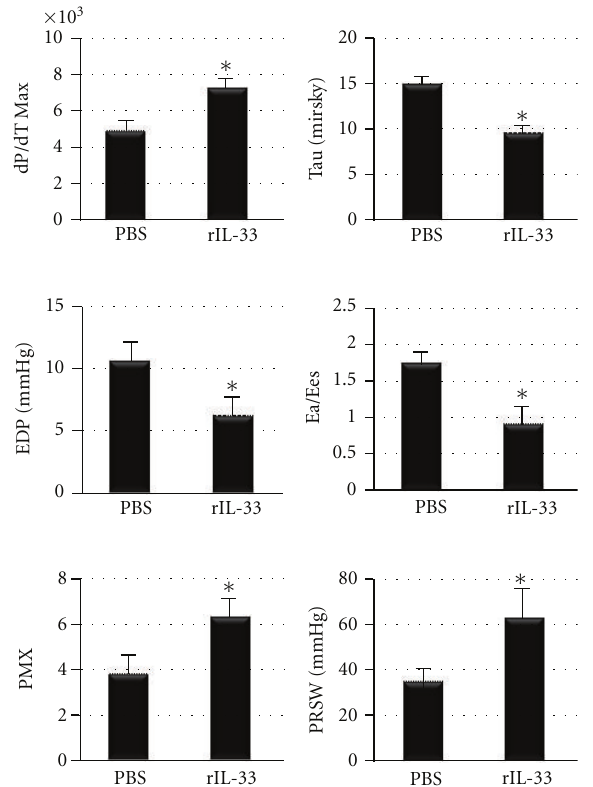
Figure 9: Summary of pressure-volume relationships at day 10pi in TLR3 − / − mice treated with recombinant IL-33 (rIL-33) or PBS every other day from day 1 to 9 pi. dP/dT Max measures the peak rate of pressure rise (mmHg/s); Tau, time constant of diastolic relaxation; EDP, end diastolic pressure; Ea/Ees, arterial elastance normalized to Ees which is left ventricular end systolic elastance (sti ff ness); PMX, maximum ventricular power; PRSW, preload recruitable stroke work. n = 10 to 12 mice/group. ∗ : P < 0 .